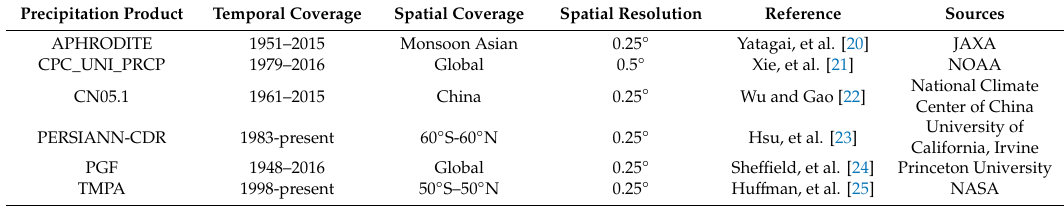
Table 2. The selected satellite-based or reanalysis precipitation